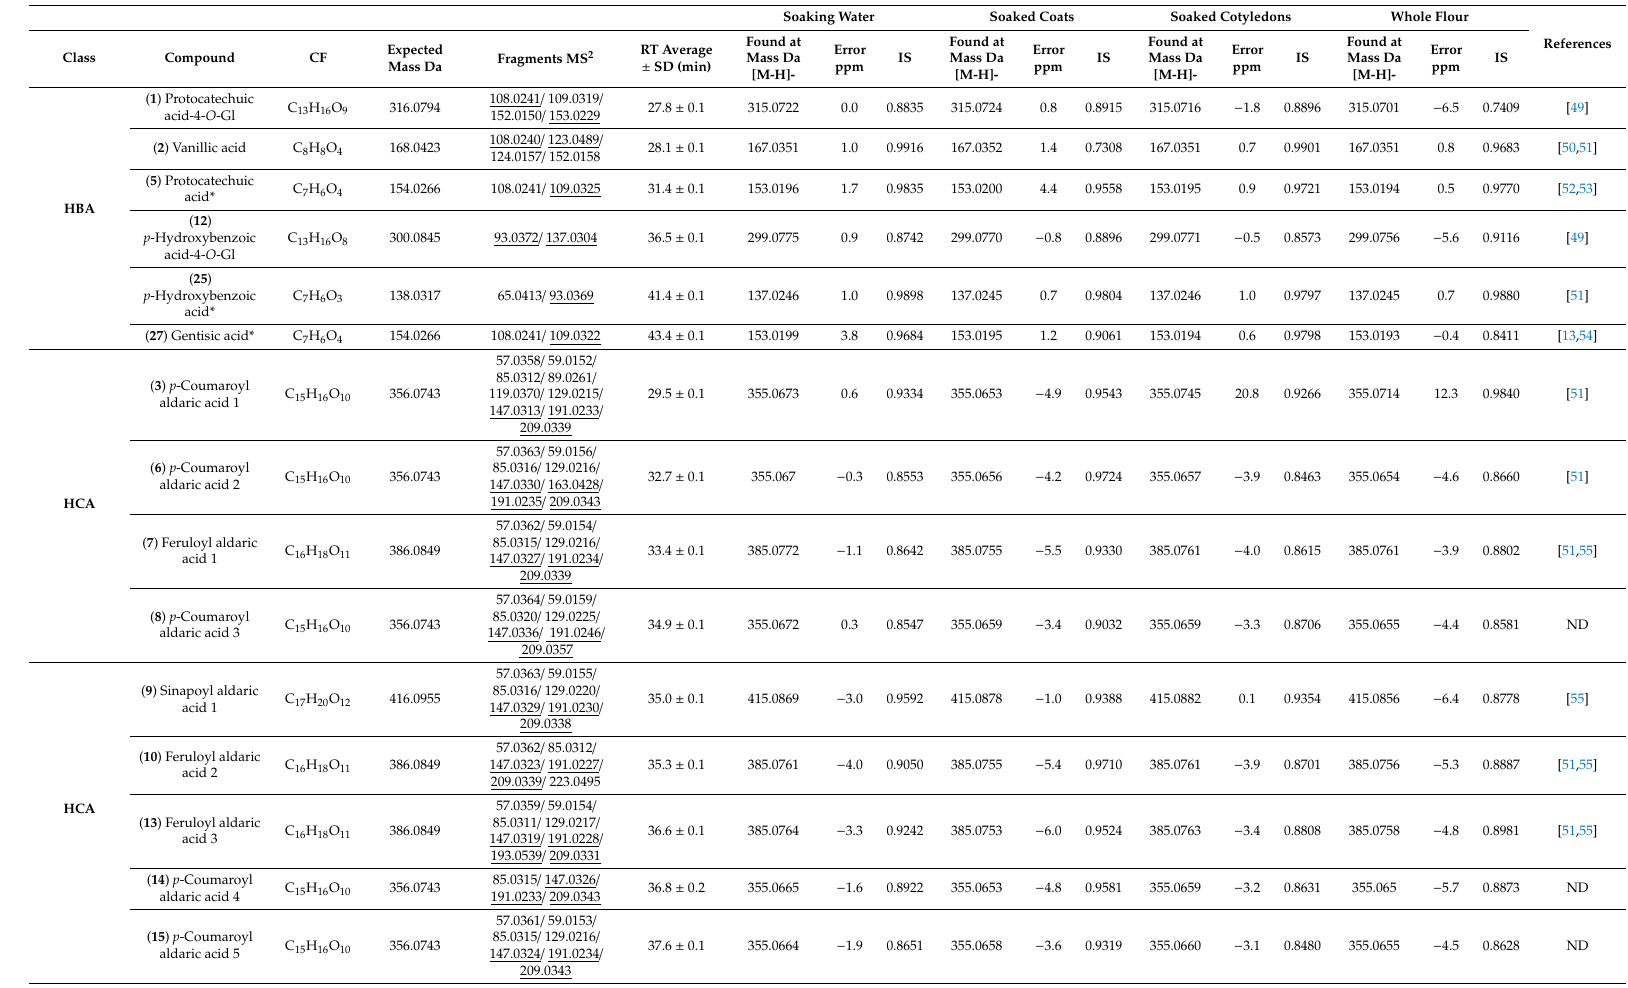
Table 3. Phenolic compounds identified in sample’s 22